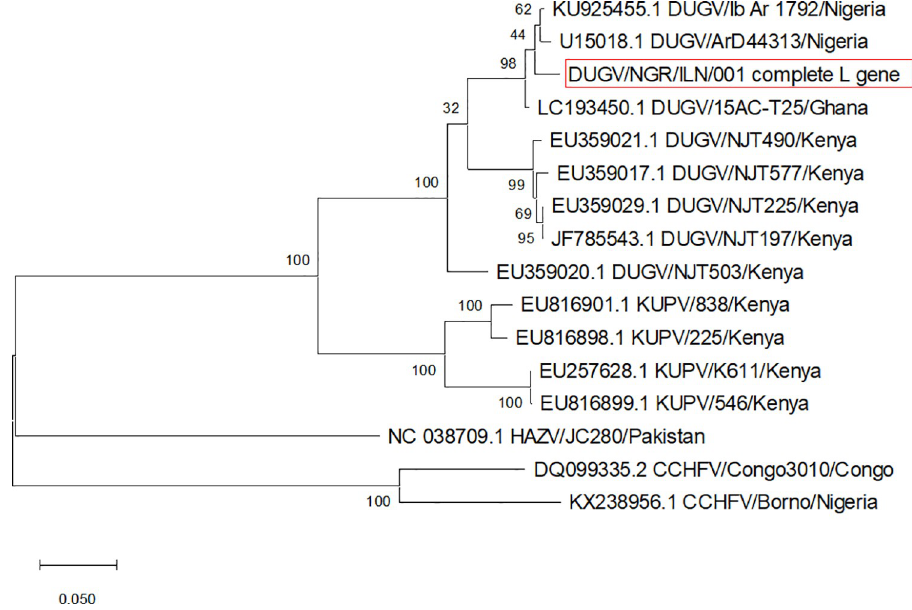
Fig 5. Phylogenetic relationship among DUGV strain recovered in this study and reference strains based on nucleotide sequence of a 12357 bp fragment of the L segment gene.